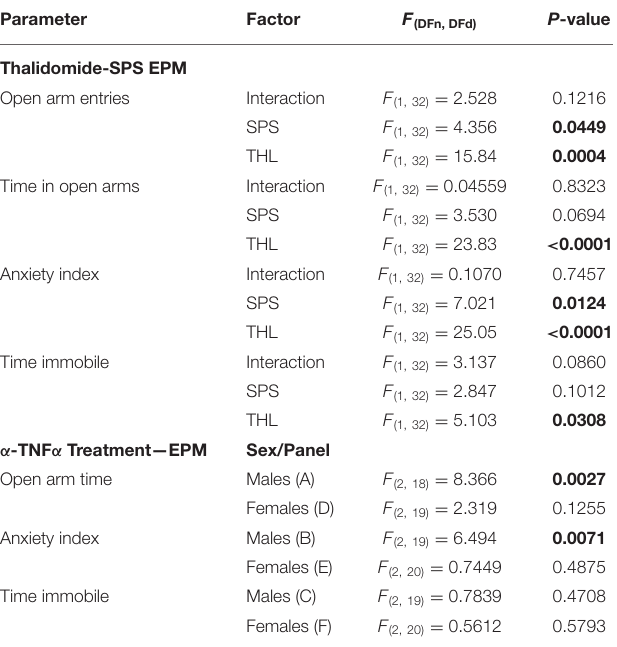
TABLE 1 | ANOVA results of anxiety-like behaviors from THL and anti-TNF- α antibody treatment studies using EPM. Parameter Factor F (DFn,DFd) P -value Thalidomide-SPS EPM Open arm entries Interaction